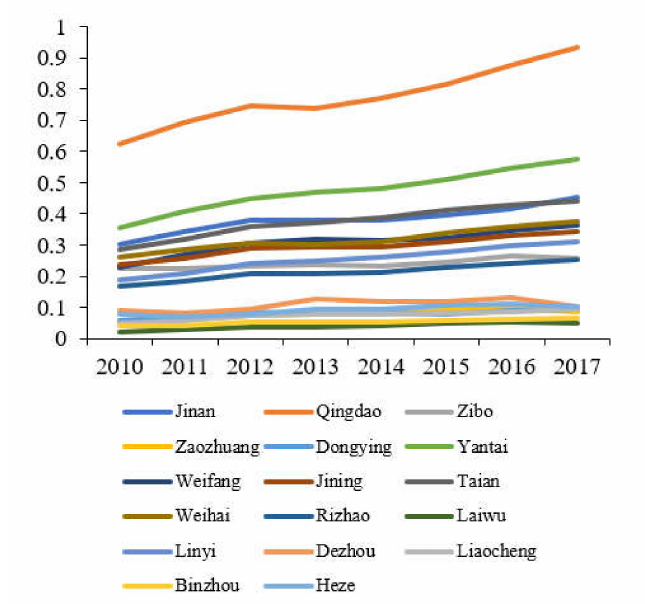
Figure 1. Evaluation value of the tourism systems of cities in Shandong